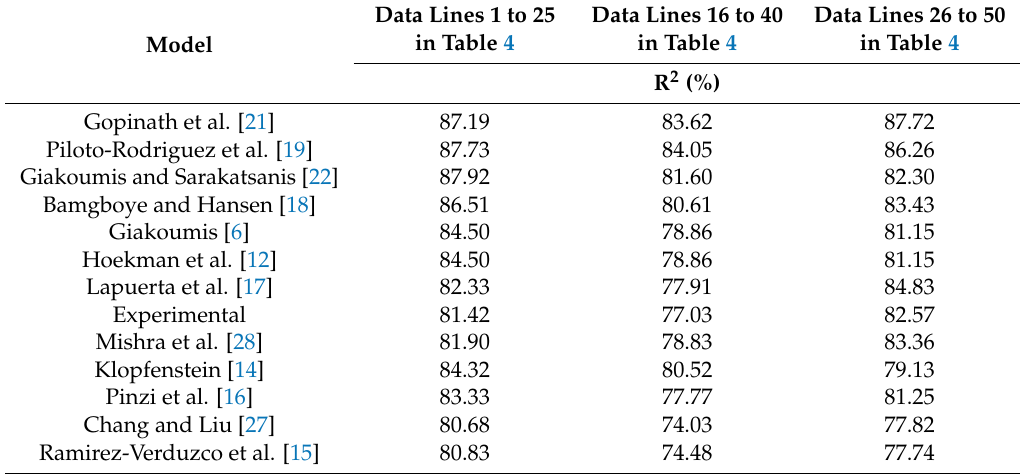
Table 8. Coefficients of determination for all models when fewer data lines from Table 4 are taken into